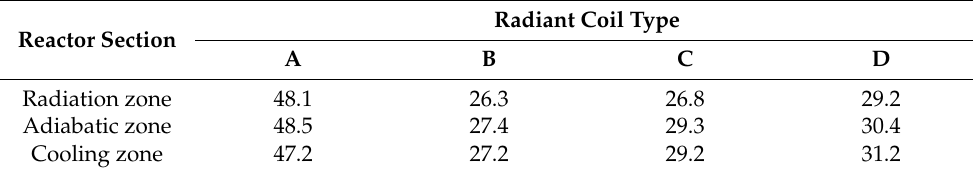
Figure 6. Schematic representation of cracking reactor designs used for kinetic model optimization by Belohlav et al. [40]. Table 2. The yield of ethylene (wt.%) at the outlets of reactor sections for the different reactor types